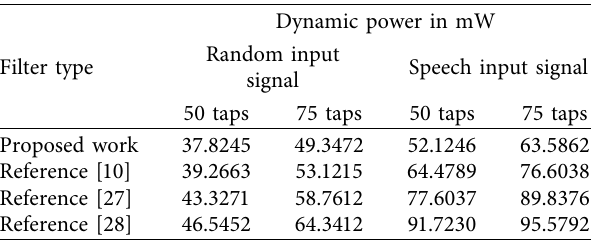
Table 2: Comparison of dynamic power conception of the con- ventional and proposed FIR filters.